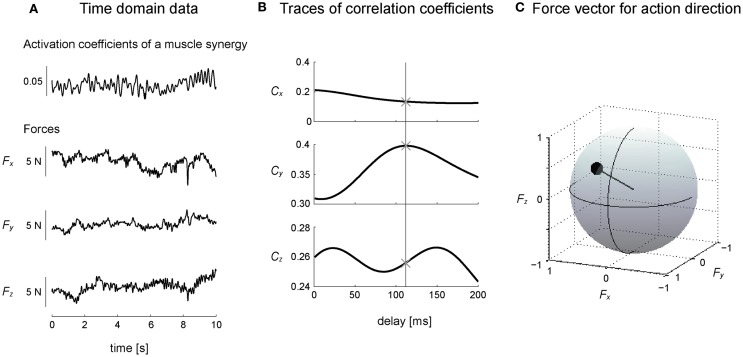
Calculation of action direction. (A) A representative trial is shown in the time domain, where the subject maintained a desired isometric force around the right ankle, which arose from the activation of a muscle synergy. (B) Cross-correlation between activation coefficients of a muscle synergy and each force component yielded the traces of correlation coefficients peaking at time lag (between EMGs constructing activation coefficients of the muscle synergy and force) about 100 ms. The time-to-peak is shown as a vertical line (see detail in Section “Materials and Methods”). ×, the point in which the most peak magnitude of the correlation coefficients was observed. (C) Force vector was determined as a unit vector based on the correlation coefficients of three components in three-dimensional force space. The correlation coefficient was described as the radius of a plot on the surface of unit sphere. These procedures were corresponding to a block diagram surrounded by a dashed line in Figure 2.